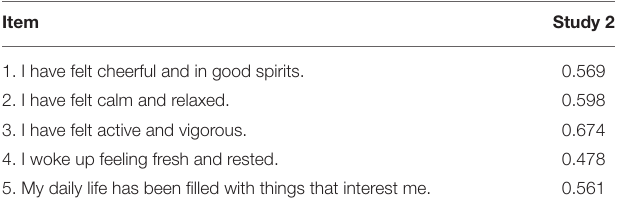
TABLE 2 | Exploratory factor analysis with principal component analysis on WHO-5 items.